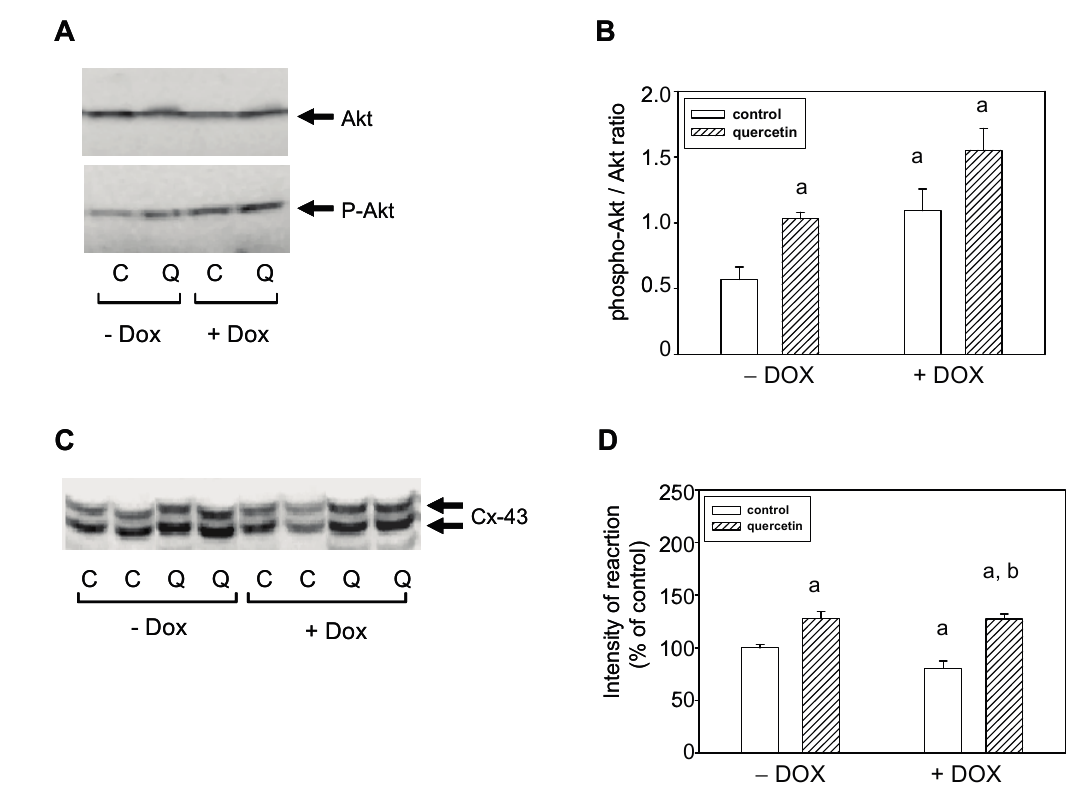
Figure 7. Effect of QCT and DOX on Akt kinase and connexin-43. ( A ) Western blot records showing the changes in protein levels and specific phosphorylation of Akt kinase. The changes in activation of Akt kinase were determined using an antibody which reacts with Akt kinase phosphorylated specifically on Ser473; ( B ) The quantification of Akt kinase phosphorylation (activation). Data were obtained from western blot records and are expressed as a ratio of content of phosphorylated Akt kinase to total Akt kinase. Each bar represents mean ± S.E.M. of seven tissue samples per group. Statistical significance is revealed by Student’s unpaired t -test, a p < 0.05 vs. control saline-treated ( − DOX) rats; b p < 0.05 vs. DOX-treated (+DOX) rats; ( C ) Protein levels of Connexin-43 (Cx-43) were determined by western blot analysis using specific antibody. The upper Cx-43 band represents the expression of highly phosphorylated Cx-43, while the lower band corresponds to Cx-43 phosphorylated to a lower extent (degree); ( D ) Quantification of content of the lower phosphorylated form of Cx-43. Bars represent mean ± S.E.M. of measurements of seven independent tissue samples per group. Statistical significance is revealed by Student’s unpaired t -test; a p < 0.05 vs. control saline-treated ( − DOX) rats; b p < 0.05 vs. DOX-treated (+DOX) rats. Connexin-43 (Cx-43) protein expression was analyzed using a specific antibody detecting both phosphorylated and unphosphorylated Cx-43. Doxorubicin treatment induced a reduction of Cx-43 protein, especially of low phosphorylated form of Cx-43, but quercetin treatment reversed the DOX-induced reduction of Cx-43 (Figure 7C,D). The levels of Cx-43 after application of QCT even exceed the values observed in control